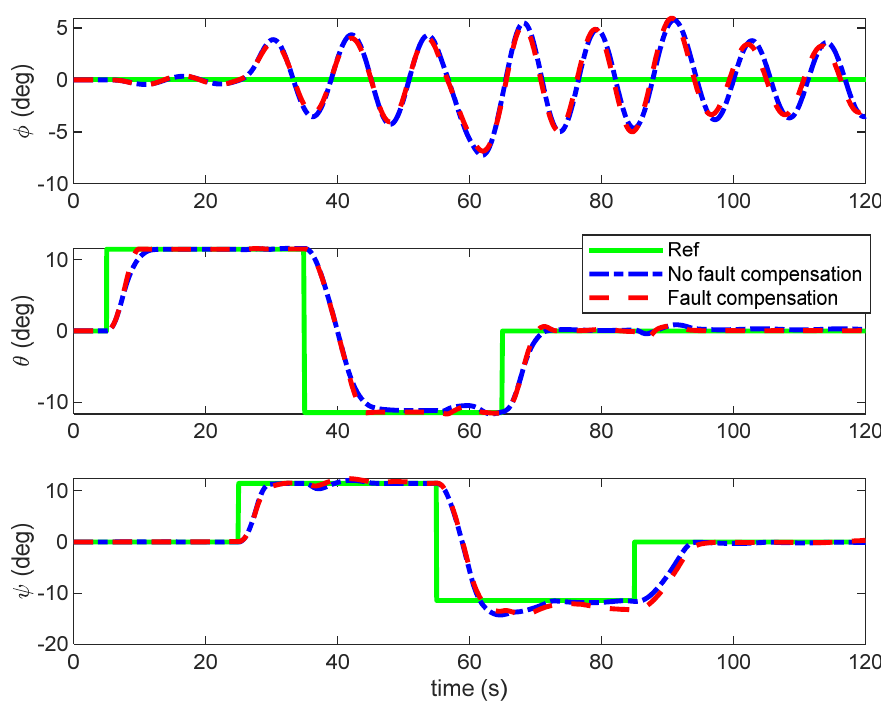
Figure 9. Tracking responses of Euler angles with and without fault compensation.